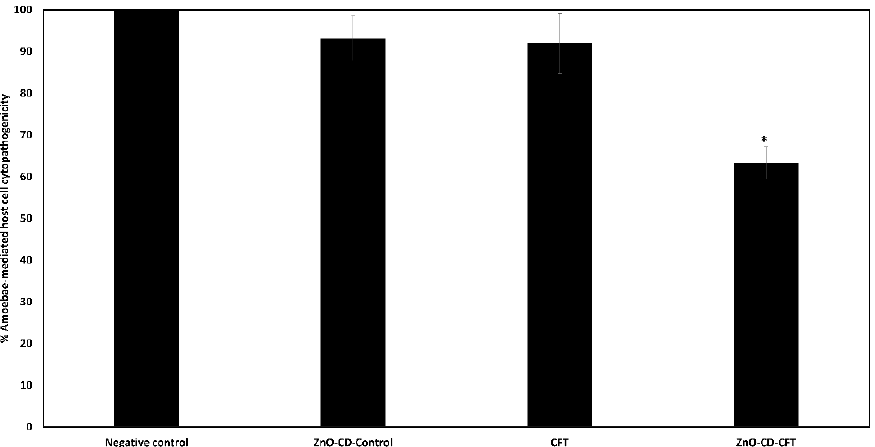
Figure 6. Cytopathogenicity assays were executed to investigate the effects of the ZnO-CD-CFT, CFT, and ZnO-CD-Control on A. castellanii mediated cytopathogenicity. Notably, the ZnO-CD-CFT reduced A. castellanii cytopathogenicity with significance. The results are presented as the mean ± standard error (* is p > 0.05).